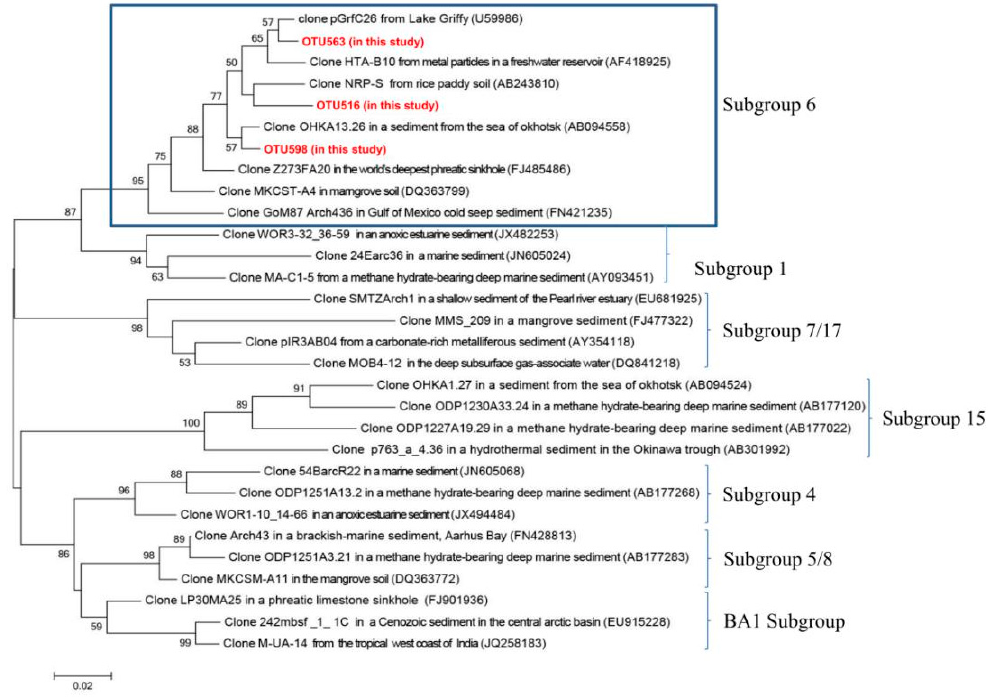
Figure 6. Neighbor-joining phylogenetic tree showing the placement of three representative bathyarchaeotal OTUs in the study in the Bathyarchaeota subgroup 6. The reference sequences of different Bathyarchaeota subgroups are according to [52]. The scale bar represents the estimated number of nucleotide changes per sequence position. Percentage numbers on nodes refer to 1000 bootstrap resamplings conducted. Only values >50% are shown.